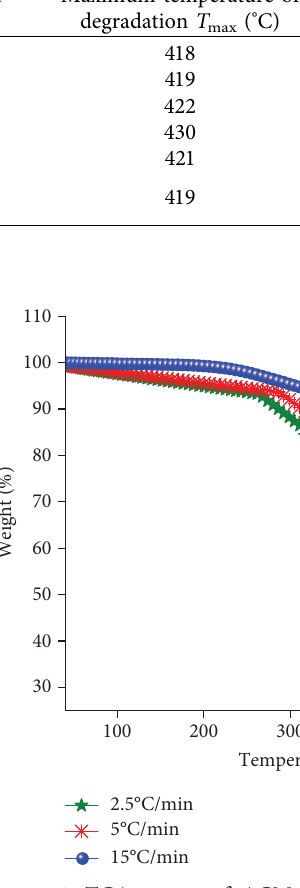
Figure 3: DTG curves of ACM composites at 10 ° C/min under nitrogen atmosphere.